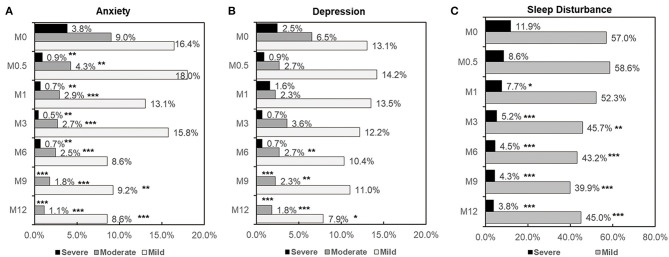
Frequency and severity of depression (A), anxiety (B), and sleep disturbance (C) at each time point in patients with HIV infection. Comparison of depression, anxiety and sleep disturbance rates between paired groups was performed by the McNemar test. Comparison of severity between two groups was performed by Chi-square test. p < 0.05 was considered significant. *: 0.01 < p < 0.05 compared to M0; **: 0.001 <p < 0.01 compared to M0; ***p < 0.001 compared to M0.